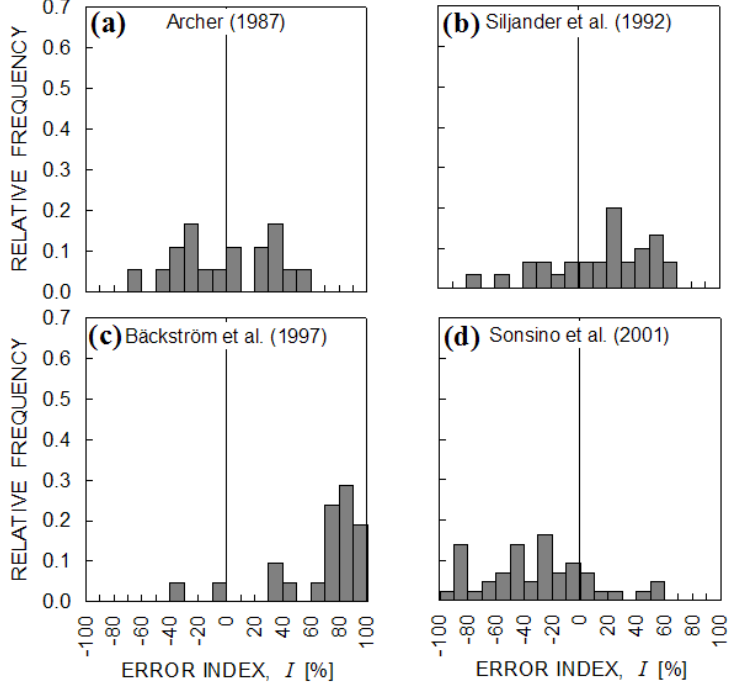
Figure 5: Error index distribution for each experimental data set analysed